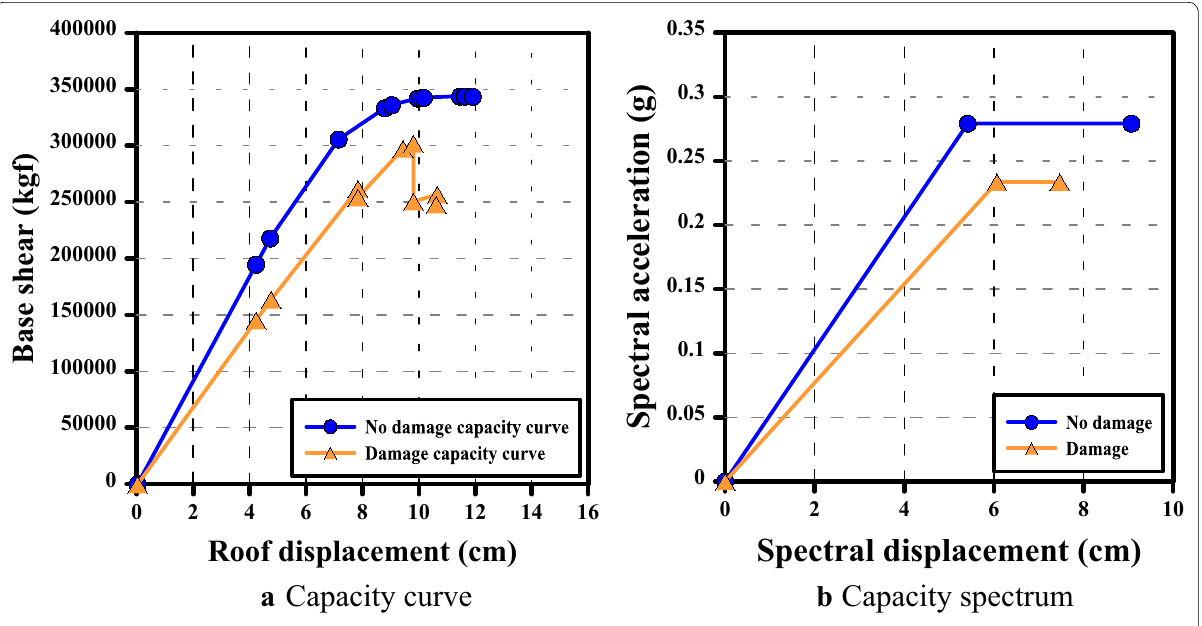
Fig. 24 Seismic performance of the selected building obtained using the pushover analysis.